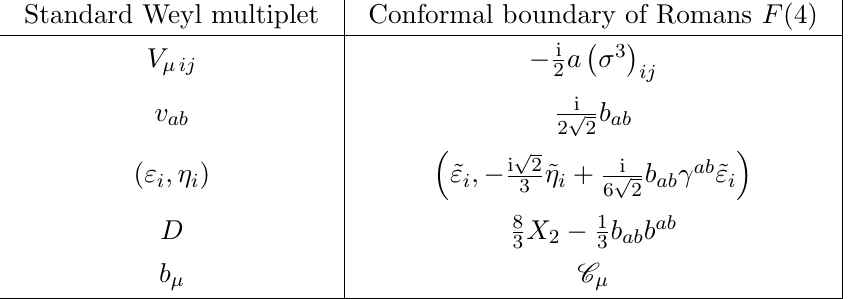
Table 10. Dictionary between the (cid:12)elds in the standard Weyl multiplet in the notation of [139],